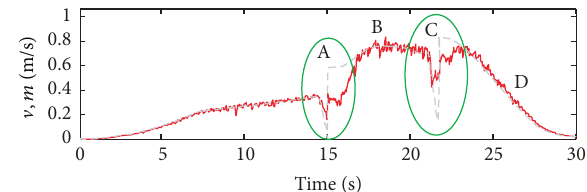
Figure 11: Linear velocity performed by the robot, V (red continuous line), and velocity generated by the Timing Control, 𝑚 . Capital letters identify snapshots illustrated in Figure 10.